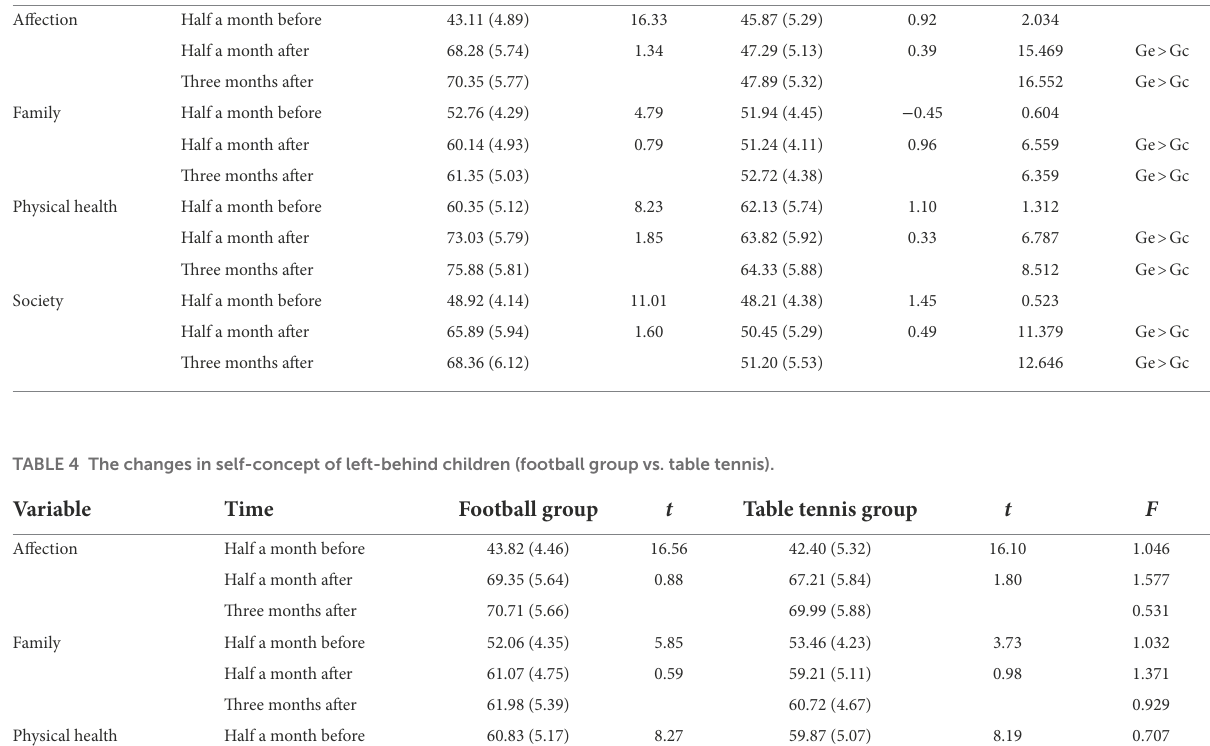
TABLE 3 The changes in self-concept of left-behind children (experiment group vs. control group). Variable Time Experimental group t Control group